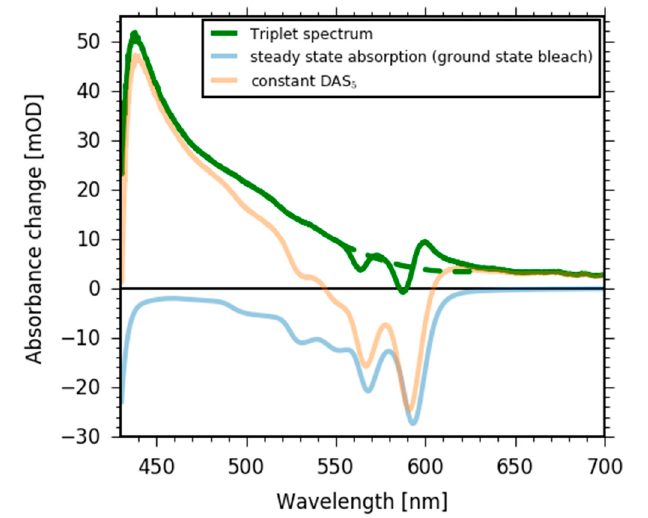
Figure 8. Triplet absorption spectrum (green line) calculated by subtracting the ground state bleach from the 10,000 ps DAS spectrum. The two dips and the following small positive peak are due to small calibration errors and resolution differences. The dashed line shows a possible correction of the spectrum.